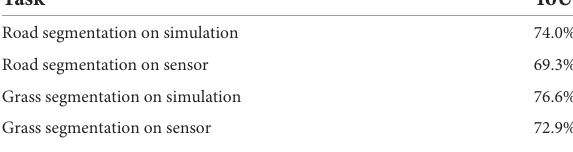
TABLE 4 Computation time, performance, and weights for heat map generation with the binarized fully convolutional network (FCN) on sensor.